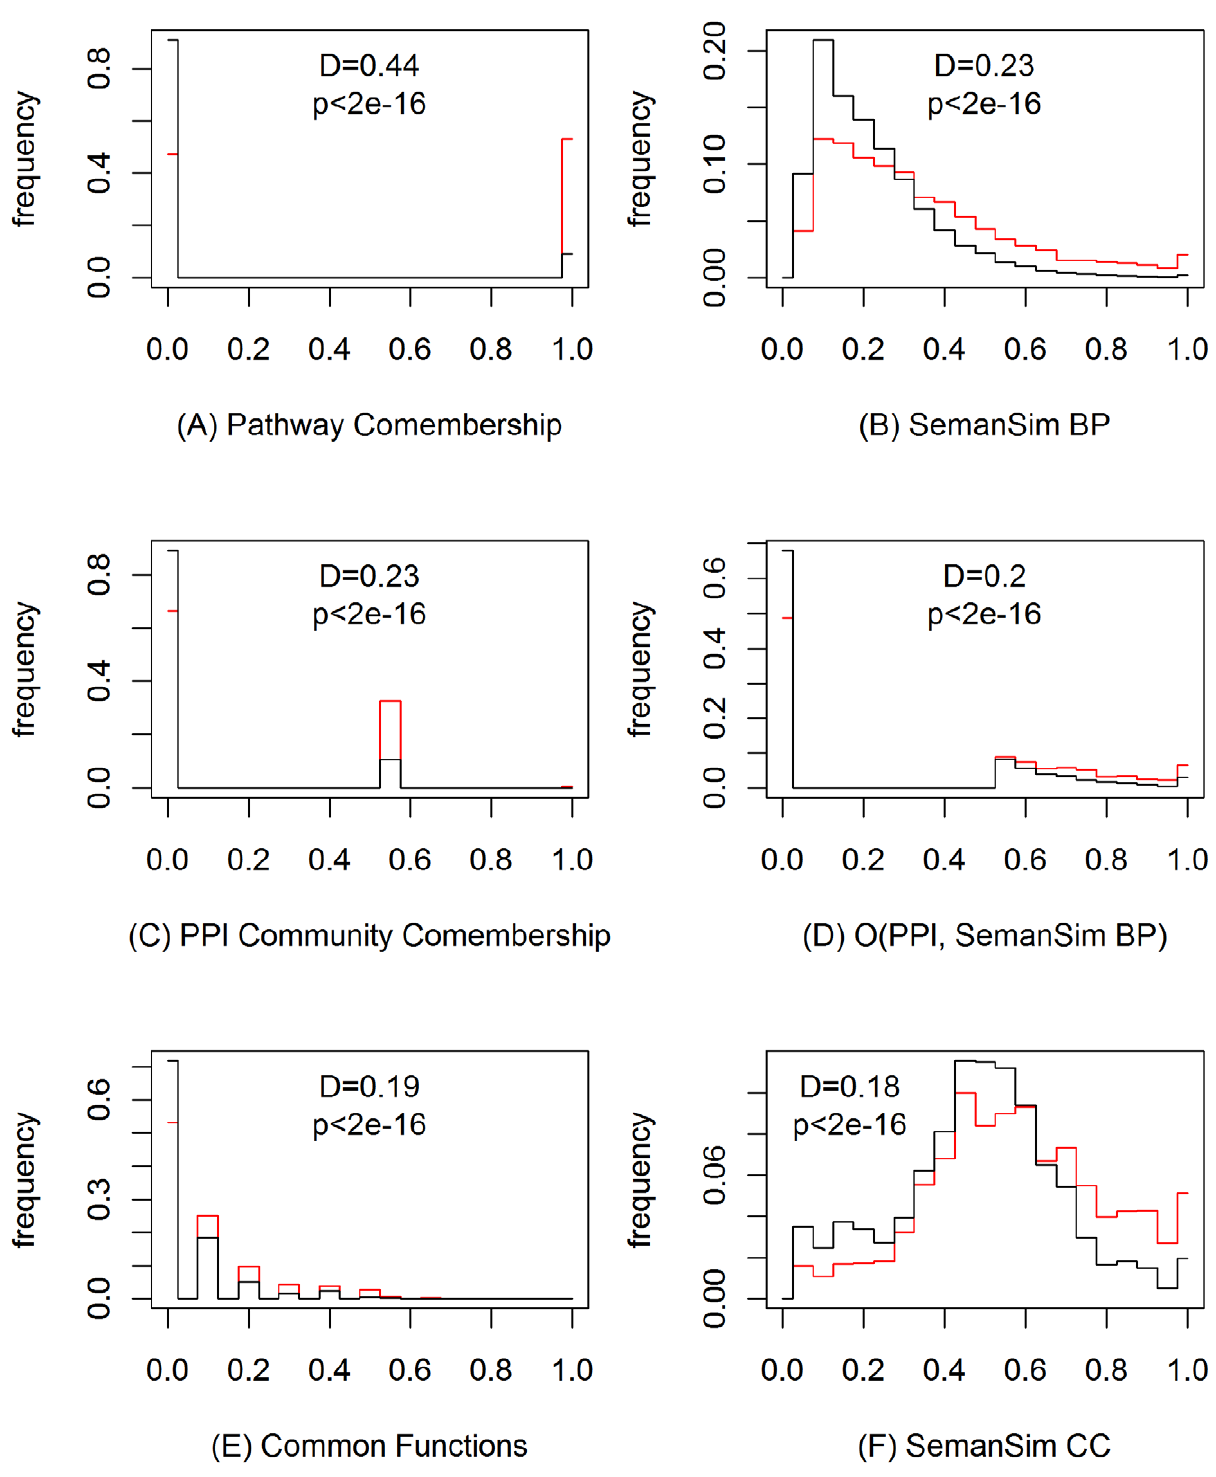
Figure 2. The 6 most discriminative SL-independent features used in our MNMC prediction approach. The Kolmogorov-Smirnov (KS) test is used to capture the difference of the distributions of a feature in the SL and non-SL classes. The D-statistics and p-values of the KS test are shown here. The features from the left to the right and top to bottom are: (A) Pathway Comembership — the number of pathways that two genes belong to, (B) SemanSim BP — similarity of two genes using their annotations to GO Biological Process terms and the semantic similarity between the terms, (C) PPI Community Comembership — the number of PPI communities that two genes belong to, (D) O(PPI, SemanSim BP) — an overlay feature from the PPI and SemanSim BP based networks, (E) Common Functions — the number of common functions that two genes belong to, (F) SemanSim CC — similarity of two genes using their annotations to GO Cellular Component terms and the semantic similarity between the terms. A description of all the features used in our study can be found in Table S1 in Text S1.